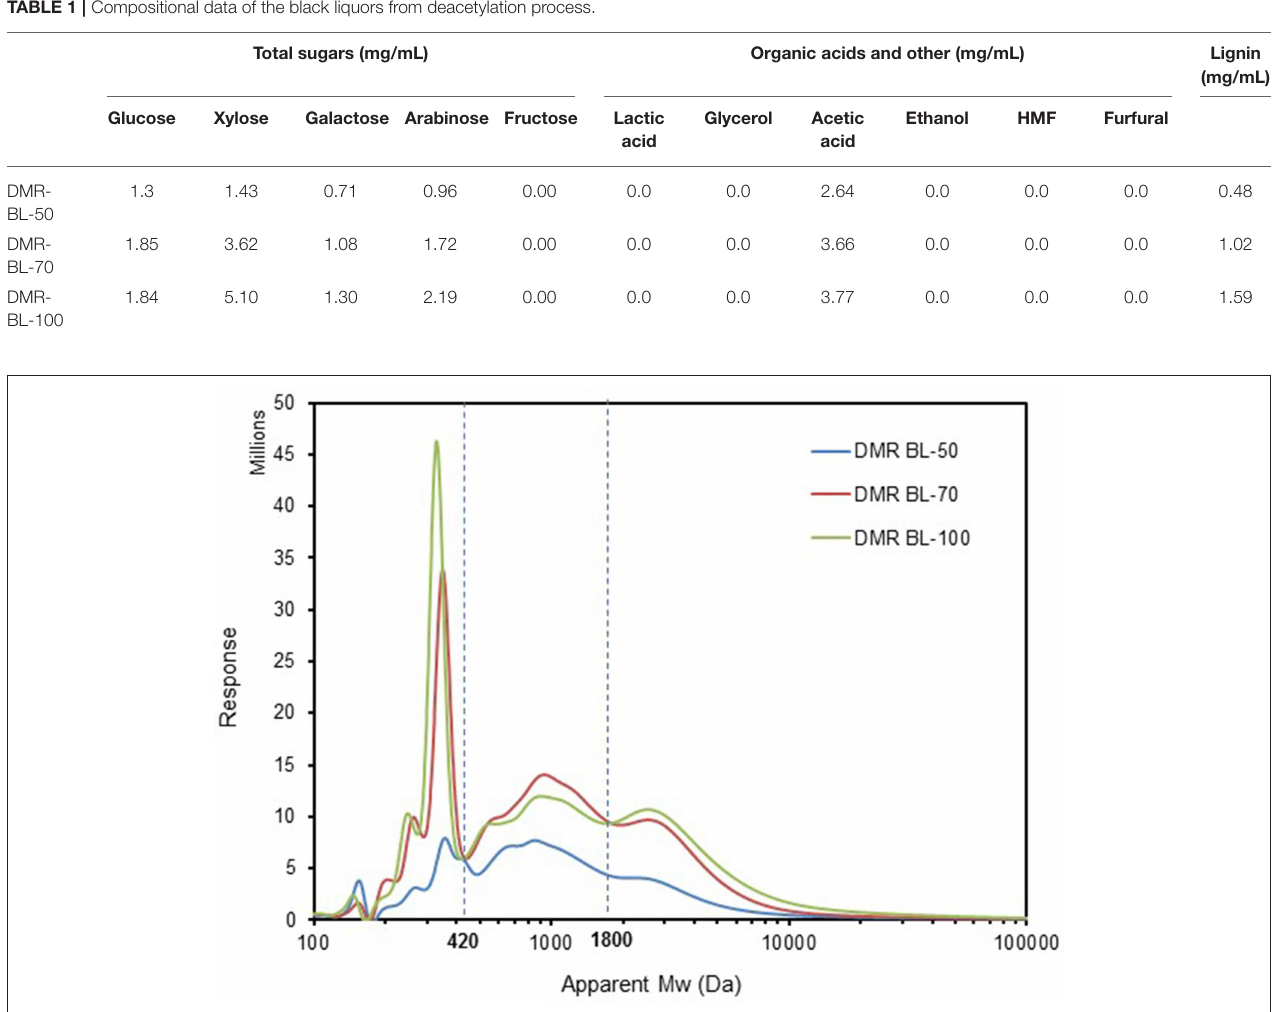
FIGURE 1 | Gel permeation chromatograms of three black liquor